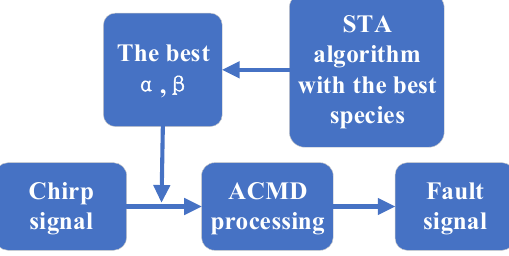
Figure 2. Optimized adaptive chirp mode decomposition (ACMD) method.